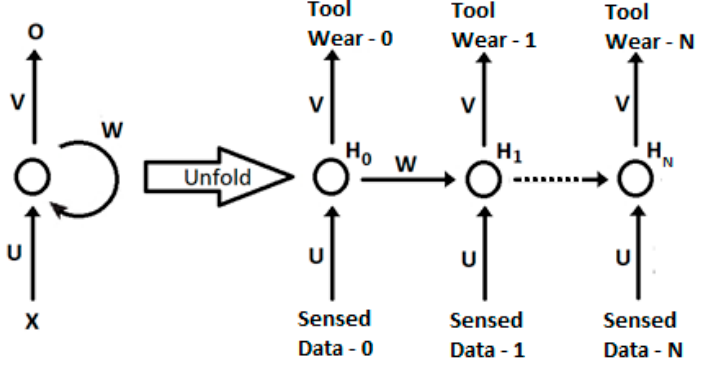
Figure 6. Unfolding of the recurrent neural network for tool wear classification.